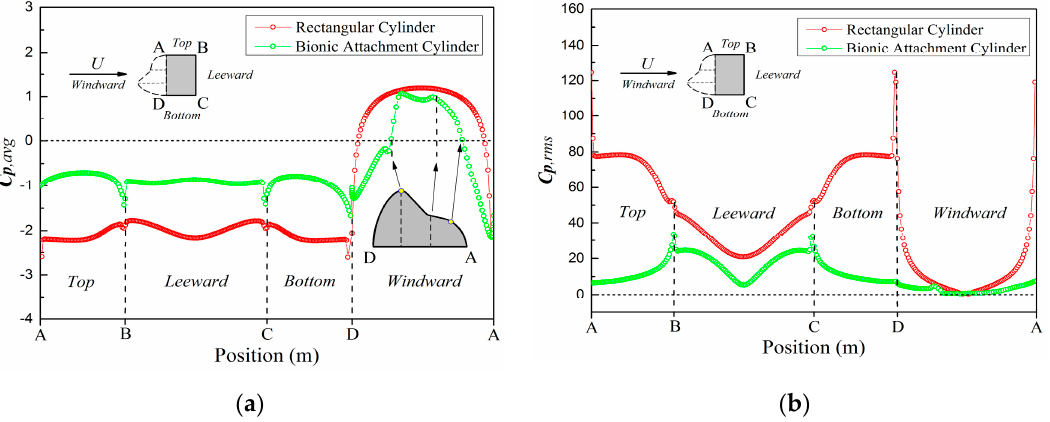
Figure 8. Pressure coefficient distribution around cylinders. ( a ) Time-average pressure coefficient and ( b ) root-mean-square pressure coefficient.